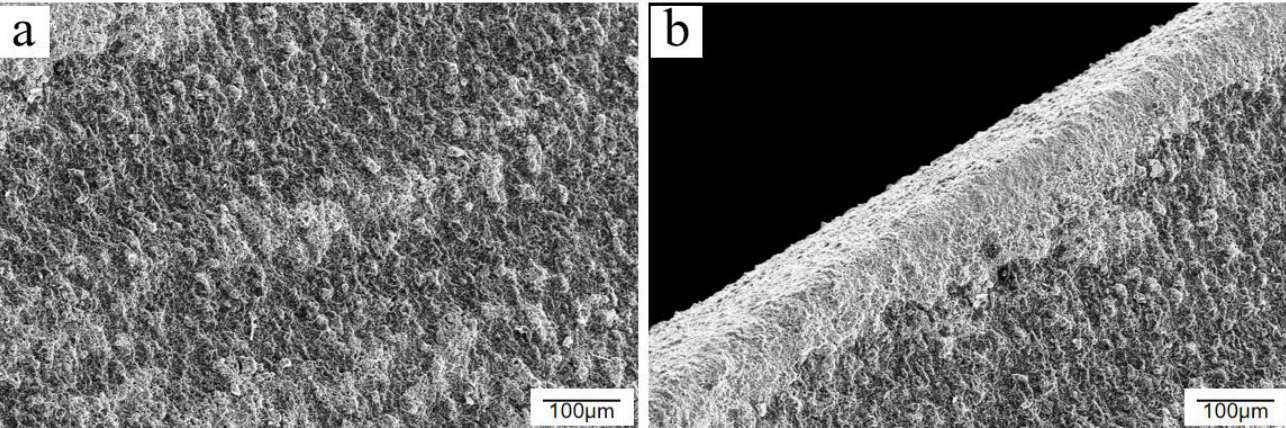
Figure 4. Comparison of passivation effects on different regions of the sample surface: ( a ) flat passivated layer and ( b ) passivated layer at fracture.